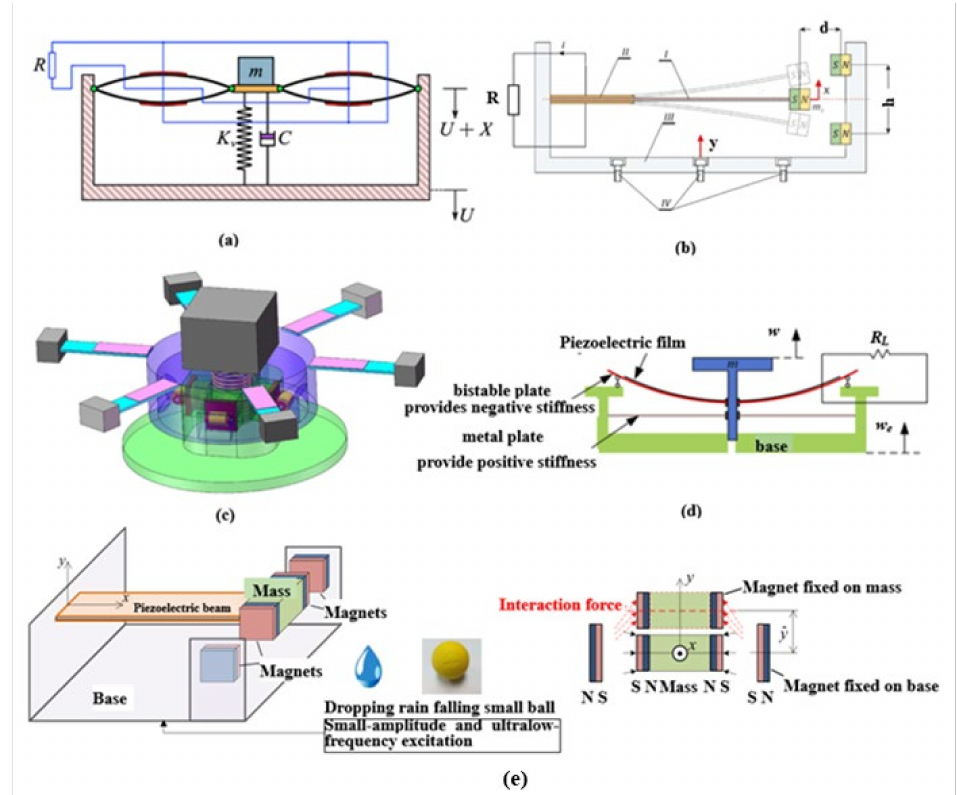
Figure 13. Typical structures based on piezoelectric QZS-SVIEH in ( a ) Simplified diagram of QZS synchronous vibration isolation and energy harvesting, ( b ) Schematic Diagram of Piezoelectric Can- tilever Beam Energy Harvesting Structure, ( c ) QZS energy harvesting physical structure, ( d ) Schematic Diagram of Vibration Isolation and Energy Harvesting Integration of Bistable Piezoelectric Compos- ite Plate and ( e ) Piezoelectric energy harvesting structure. Reprinted/adapted with permission